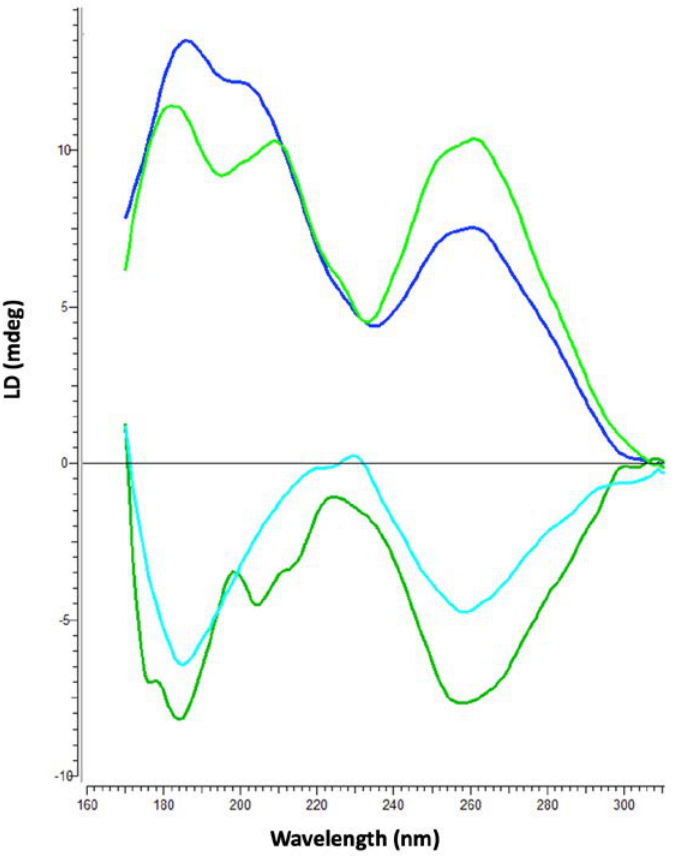
Figure 5. Observation of dsDNA ColE1 origin alignment by Hfq-CTR using SRLD. Dark green: 0 ◦ , dark blue 90 ◦ , light blue 180 ◦ , light green: 270 ◦ . No DNA alignment occurs without the protein. As previously shown, Hfq-CTR and short DNA alone do not align [35] .